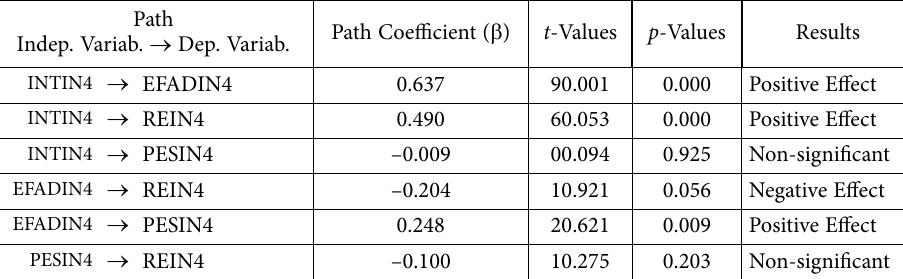
Table 12. Path coefficient